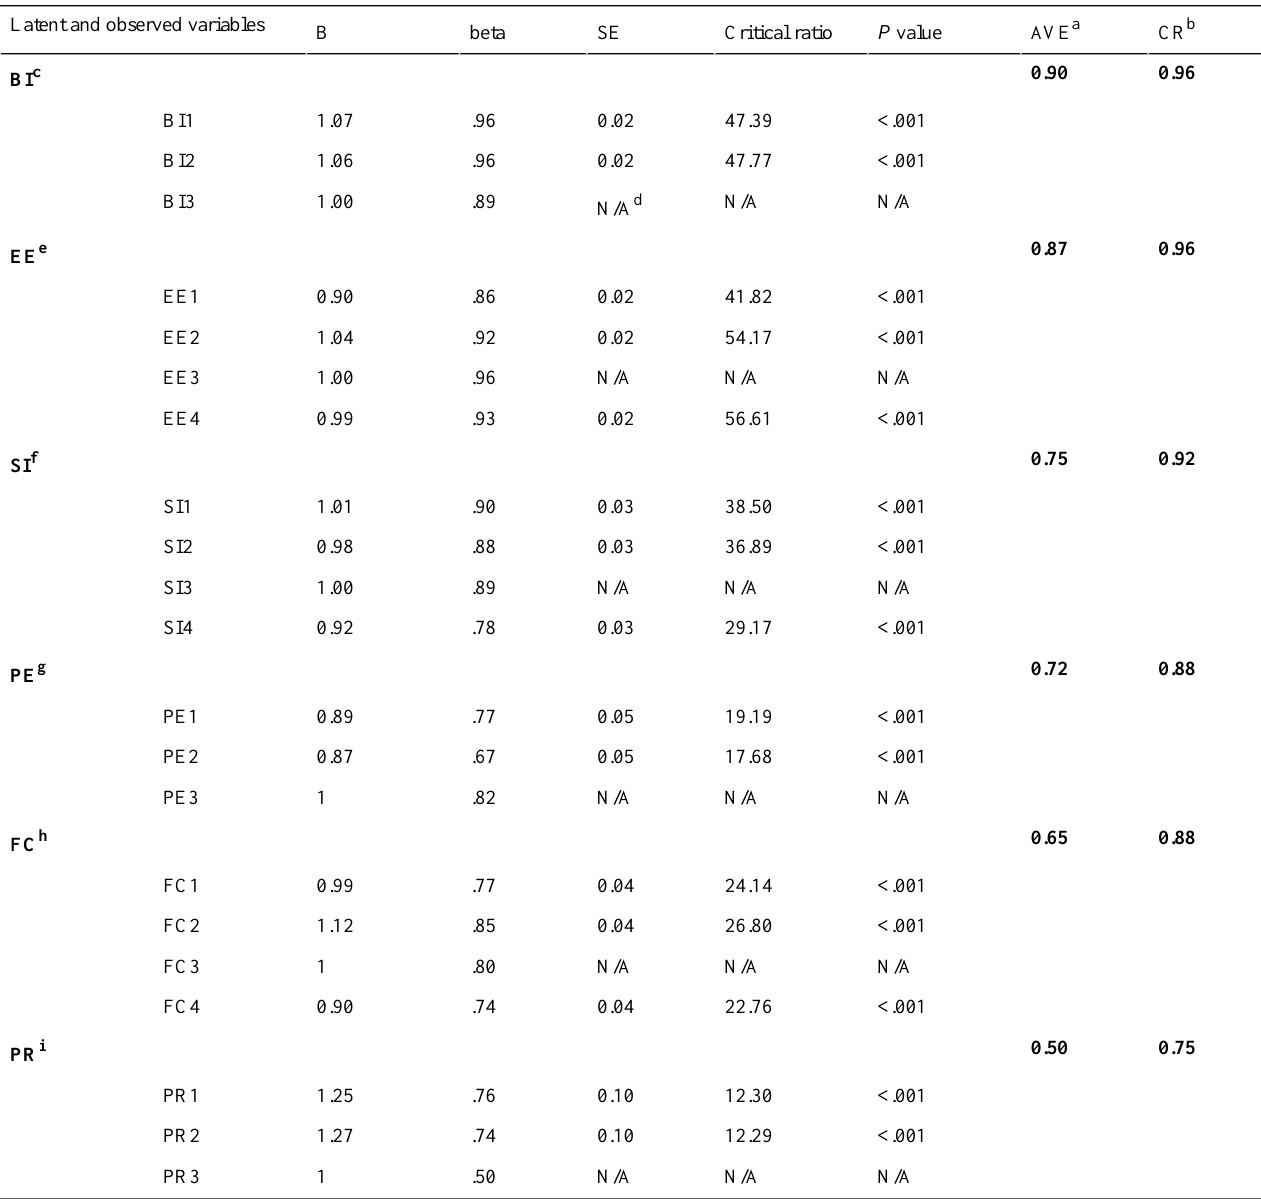
Table 5. Confirmatory factor